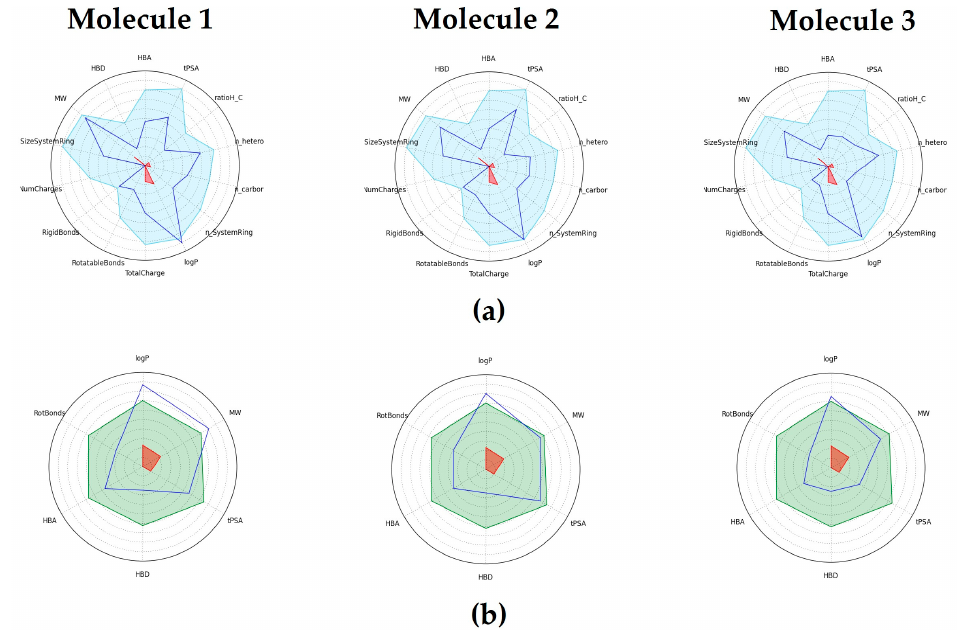
Figure 5. ( a ) Scheme of PhysChem Filter Positioning, compound values (blue line) should fall within the drug-like filter area (light blue); ( b ) Scheme of Oral Absorption Estimation, compound values (blue line) should fall within RO5 and Veber rules area (light green). The logarithm of the partition coefficient between n-octanol and water, logP; Molecular Weight, MW; Hydrogen Bond Donnors, HBD; Hydrogen Bond Acceptors, HBA; topological Polar Surface Area, tPSA; het/carbon atoms ratio, ratioH/C; Number of Heteroatoms, n_hetero; Number of Carbon Atoms, n_carbor; Number of Smallest Set of Smallest Rings, n_SystemRing.